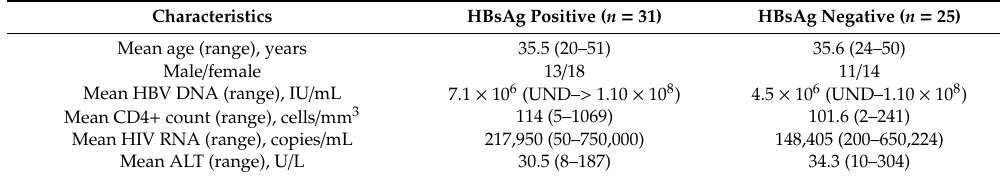
Table 1. Baseline characteristics of patients before lamivudine-based ART